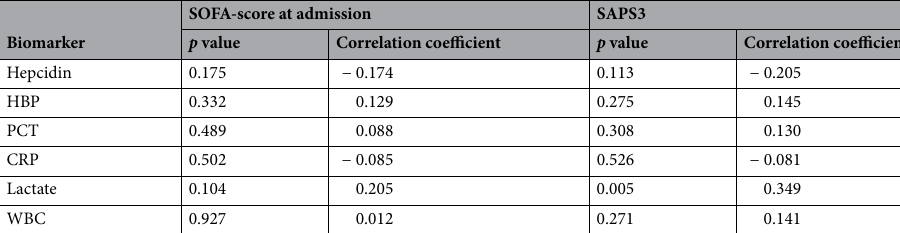
Table 6. Sequential Organ Failure Assessment (SOFA)-score and Simplified acute physiology score III (SAPS3) at admission analysed through Spearman’s rank correlation coefficient in the non-sepsis group. Hepcidin , heparin-binding protein (HBP), procalcitonin (PCT), C-reactive protein (CRP), lactate and white blood cells (WBC).